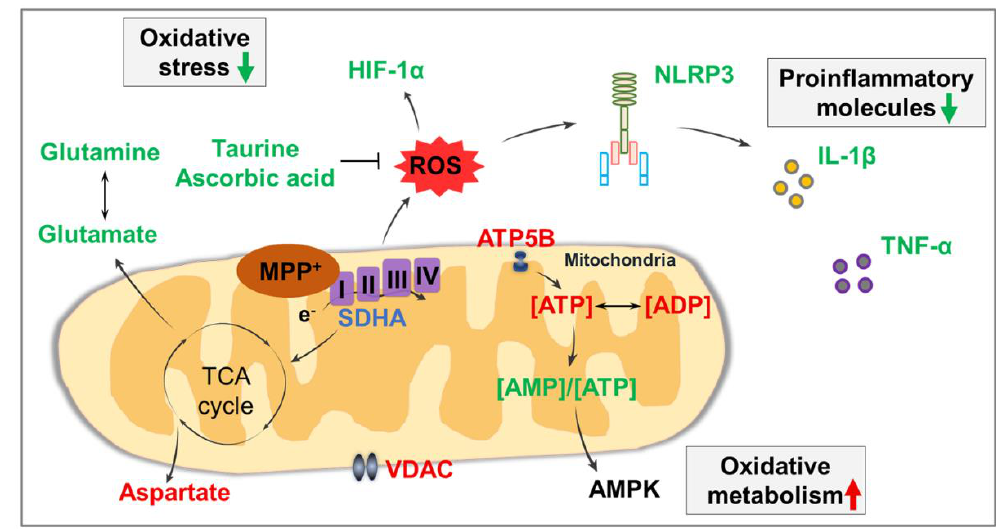
Figure 5. Summary of associations amongst affected molecules in the present study. Molecules that were significantly increased after icaritin treatment are represented in red font, those that were significantly decreased are represented in green font, and those that were significantly altered only in the presence of MPTP are represented in lilac font. Black arrows indicate metabolic processes. I–IV: respiratory chain complex I–IV; AMPK: AMP-activated protein kinase; HIF-1 α : hypoxia-inducible factor-1 α ; ROS: reactive oxygen species; SDHA: succinate dehydrogenase subunit A; TCA cycle: tricarboxylic acid cycle; VDAC: voltage-dependent anion channel.